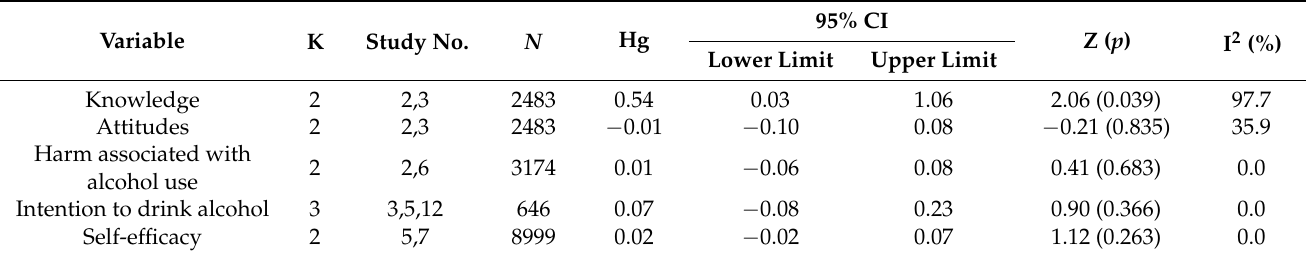
Table 5. The effect size of alcohol prevention interventions on secondary outcome